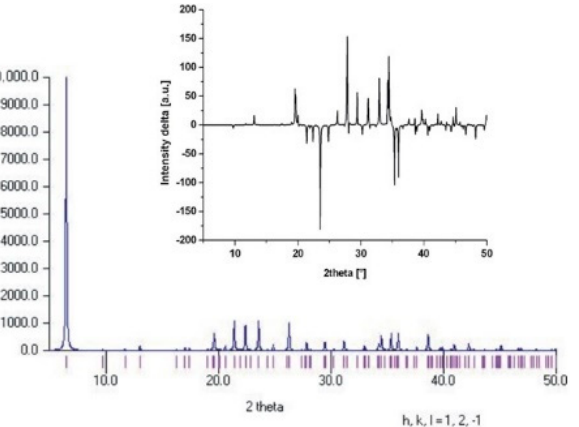
Figure 5. Calculated powder diffraction profile of the L model and difference of powder diffraction profiles for L and H models (right up).